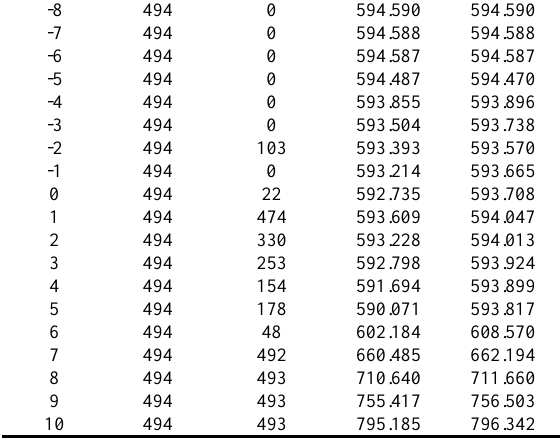
Table 7. Packets and Remaining Energy ( Scenario 1a ).